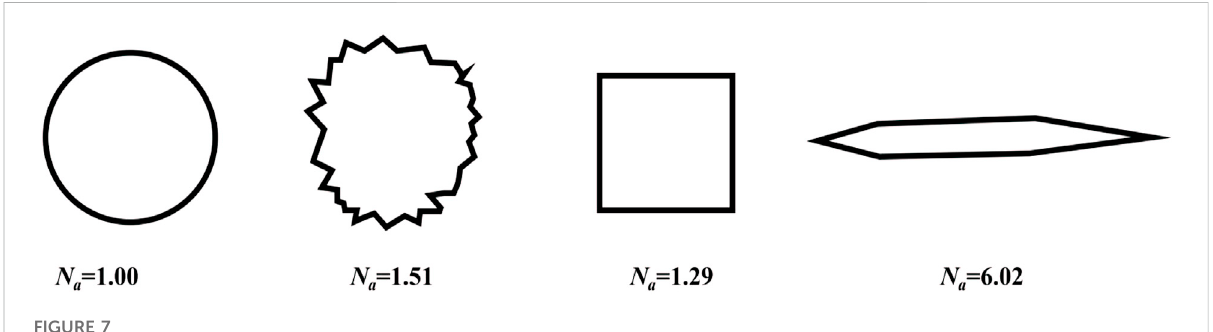
FIGURE 7 Shape factors for different